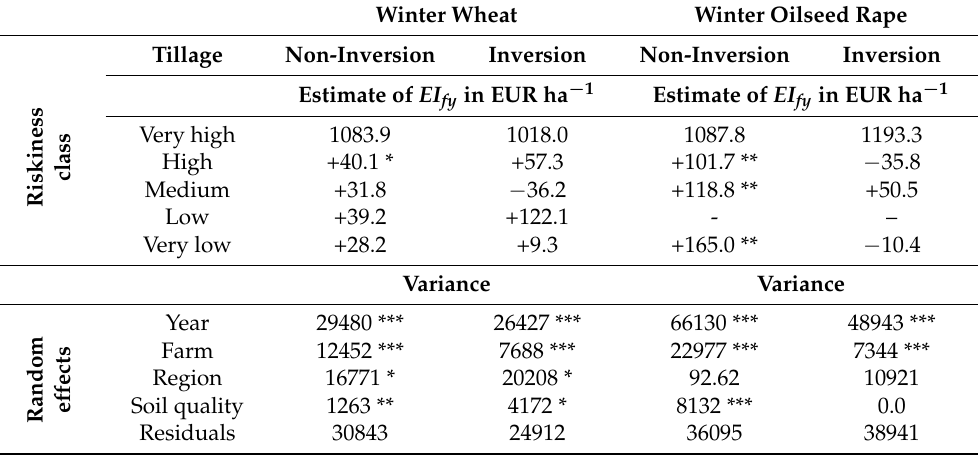
Table 4. Regression: Effect of crop sequence riskiness and tillage on ‘economic income’ ( EI fy ) (EUR ha − 1 ) in winter wheat and winter oilseed rape. Significance levels: * p < 0.05, ** p < 0.01 and *** p <